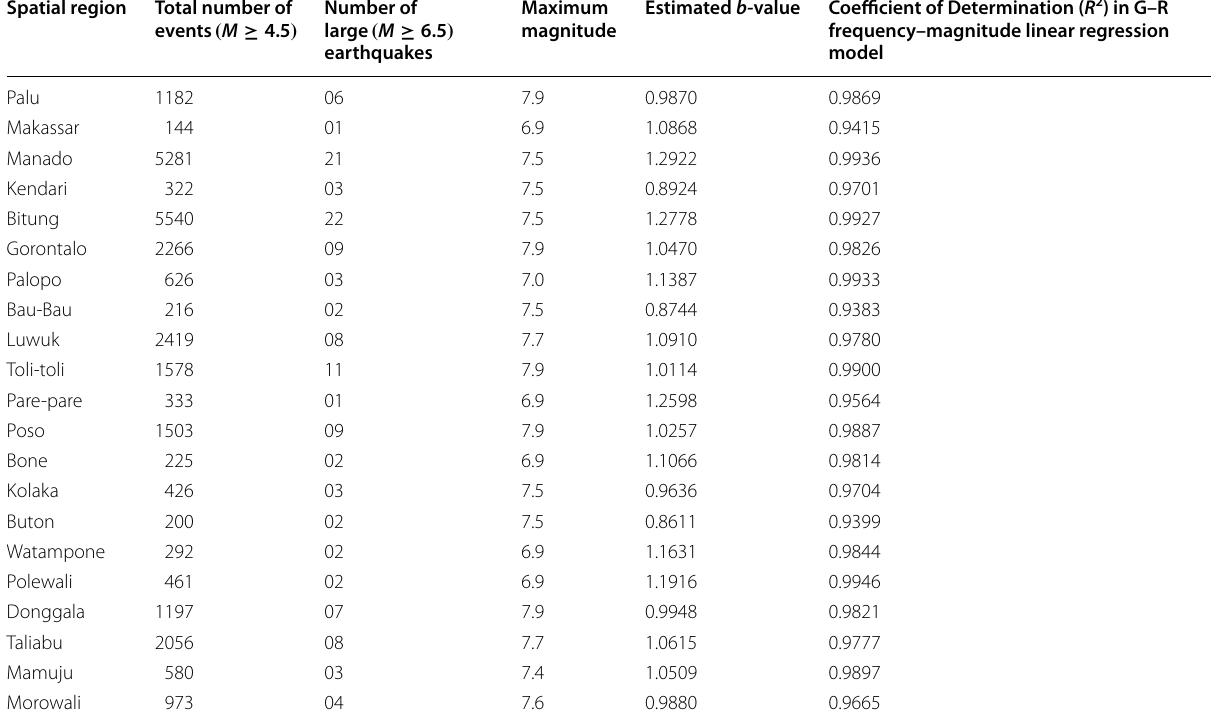
Table 4 Homogeneity of the study region shown through estimated b- values for 21 city-circle sub-catalogs Spatial region Total number of events ( M ≥ 4.5